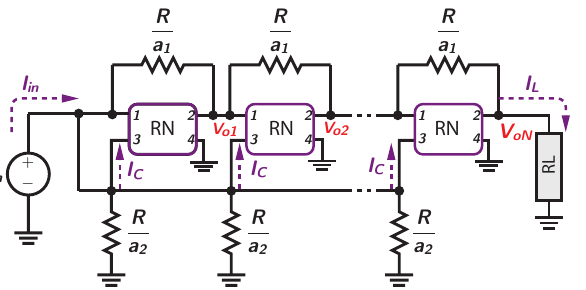
Figure 11. RN-P model representation of N-stage DCP using cascaded resistive